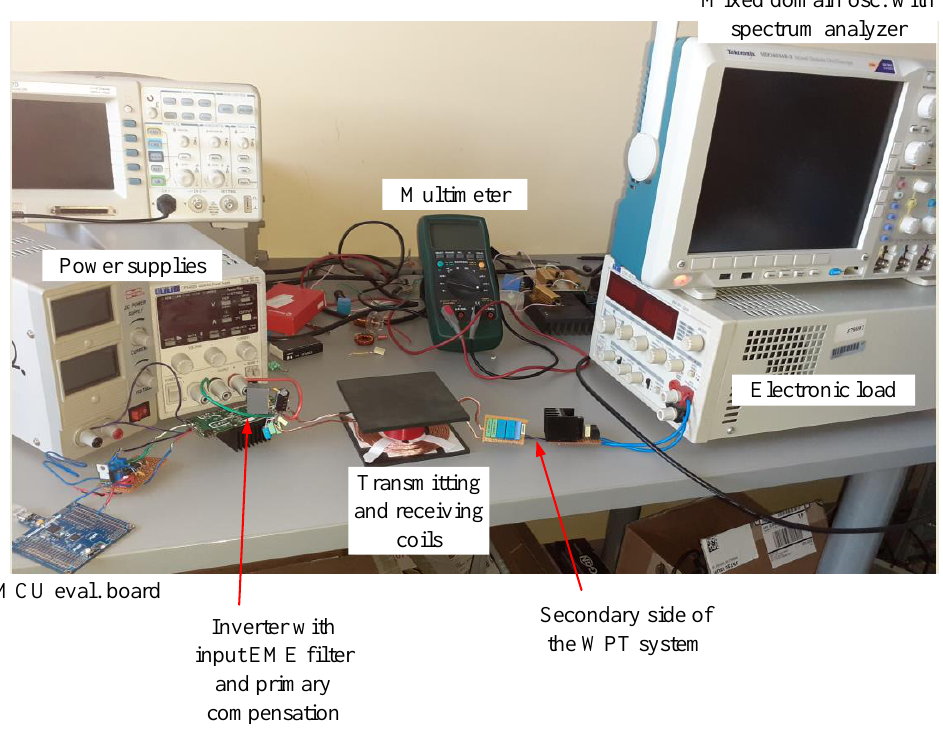
Figure 9. Image of the experimental setup. Note: DC LISN is not shown here, but it was used during the measurements of conducted EME. the measurements of conducted EME.